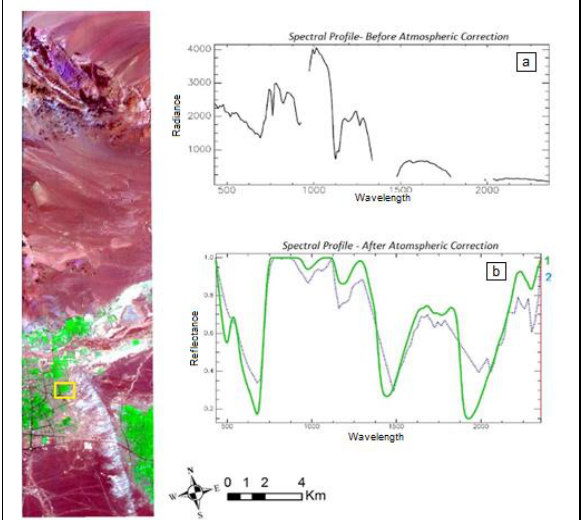
Figure 8. Feature signature before (a) and after (b) atmospheric correction